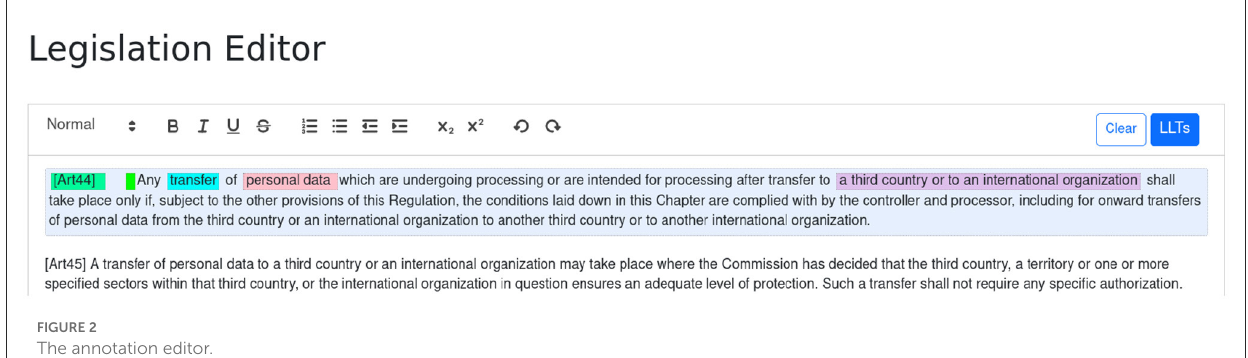
FIGURE2 The annotation